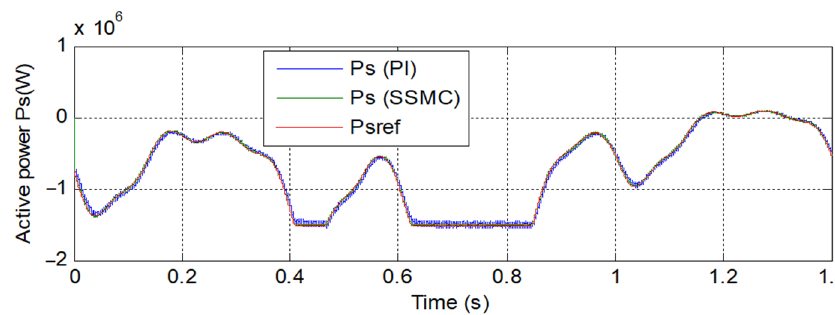
Figure 6. Active power.